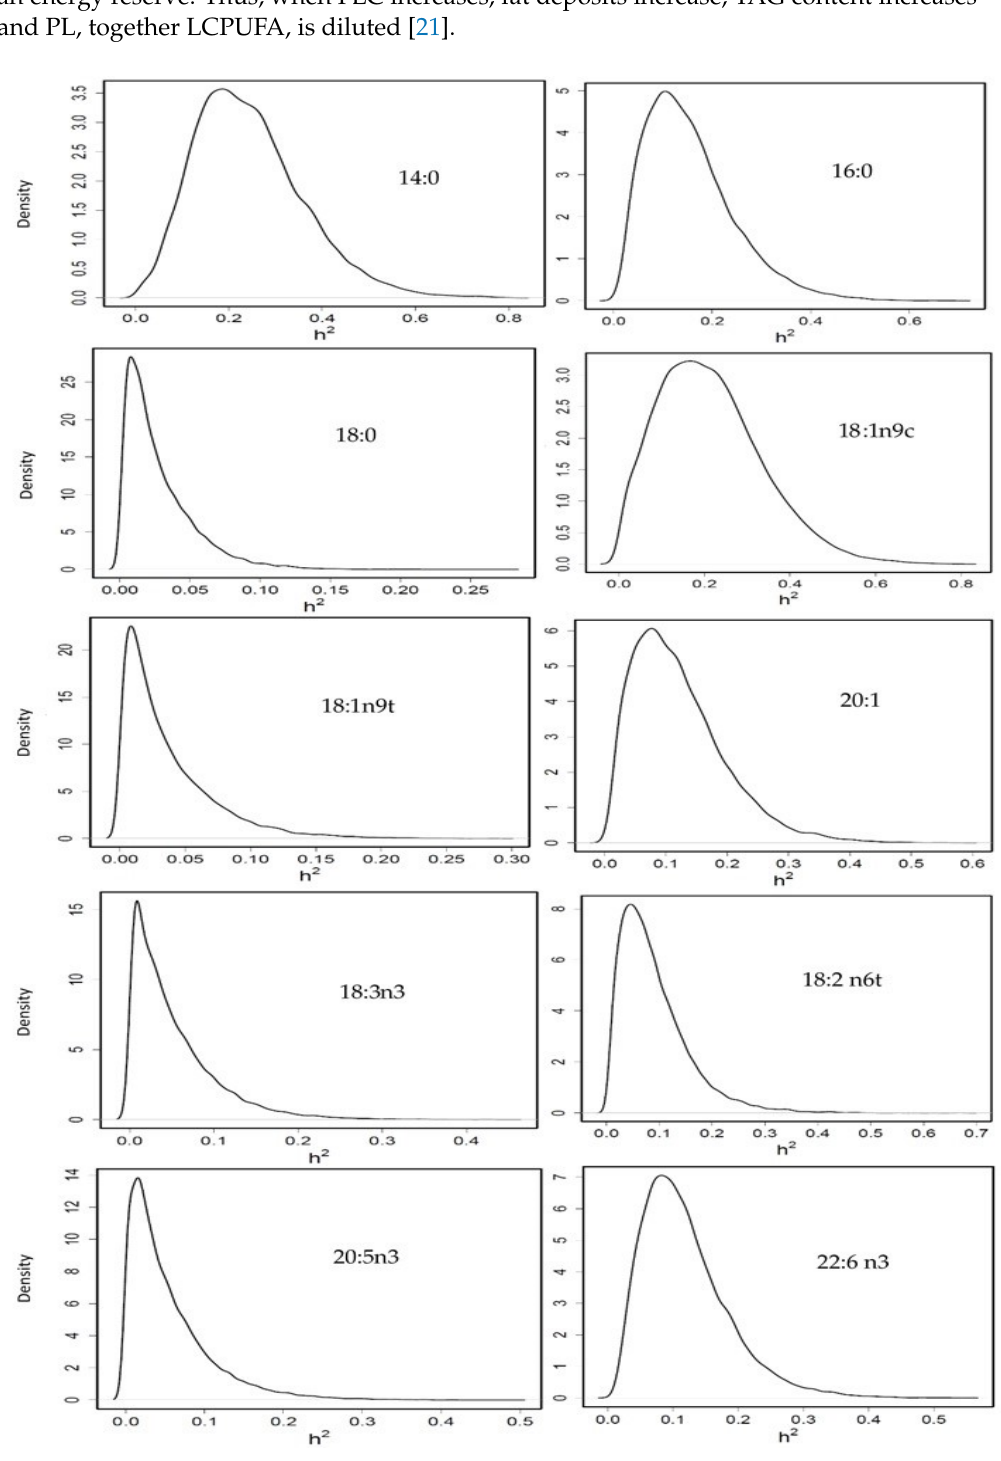
Figure 3. Posterior marginal distribution of heritabilities of fatty acids profile in gilthead seabream. h2 = heritability. n =